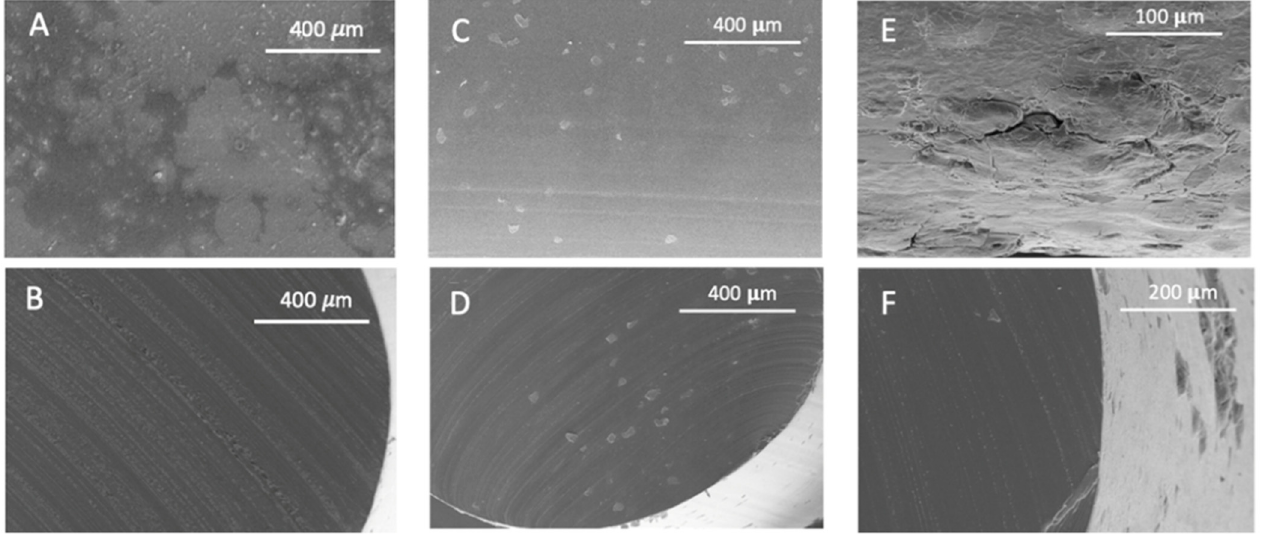
Figure 6. Appearance of raw TPU, ( A ) longitudinal and ( B ) cross section; TPU after scCO 2 contact ( C ) longitudinal and ( D ) cross section; and TPU after impregnation with MLE, ( E ) longitudinal and ( F ) cross section.